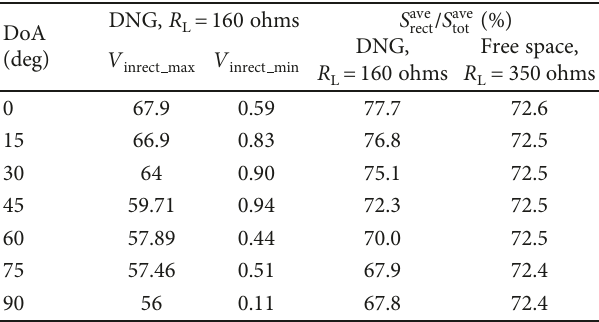
Figure 14: (a) and (b) Results versus frequency, for the input voltage of the recti fi er of the sensor “ Dipole 1-DNG ” when connected to the full wave recti fi er in cases of DoA 0deg and 45deg. Recti fi er ’ s output is connected to the R L by which maximum P L is obtained (c) available average voltage values, calculated over the UMTS band, at the input of the recti fi er, for the sensor “ Dipole 1-DNG ” and for the same dipole in free space. Electric fi eld intensity of the incident wave 1 V/m. Table 3: Results versus DoA, of the “ Dipole 1, ” positioned in front of the DNG and in free space, when connected to the full wave recti fi er. Proportion of the magnitude of the average total power S ave fi er ( S ave tot , available to the recti rect ). The values are averaged over the UMTS band, and the recti fi er ’ s output is connected to the R L by which maximum P L is